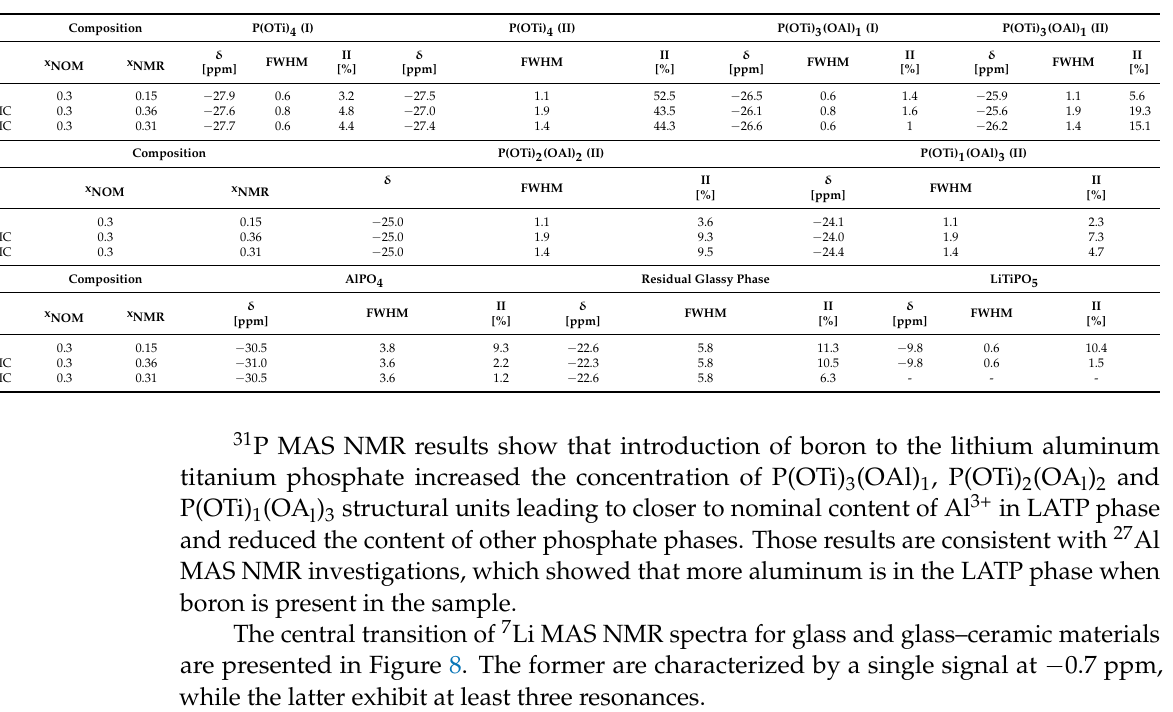
Table 3. Relative integrated intensities (II), full widths at maximum height (FWHM) and isotropic chemical shifts ( δ ) of the line-shapes used to simulate 31 P MAS NMR spectra shown in Figure